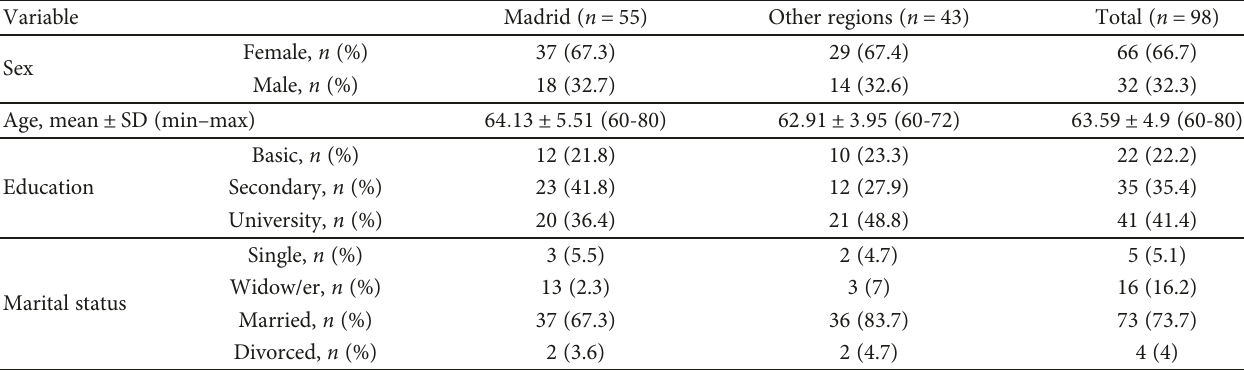
Table 1: Characteristics of the study participants ( n = 98